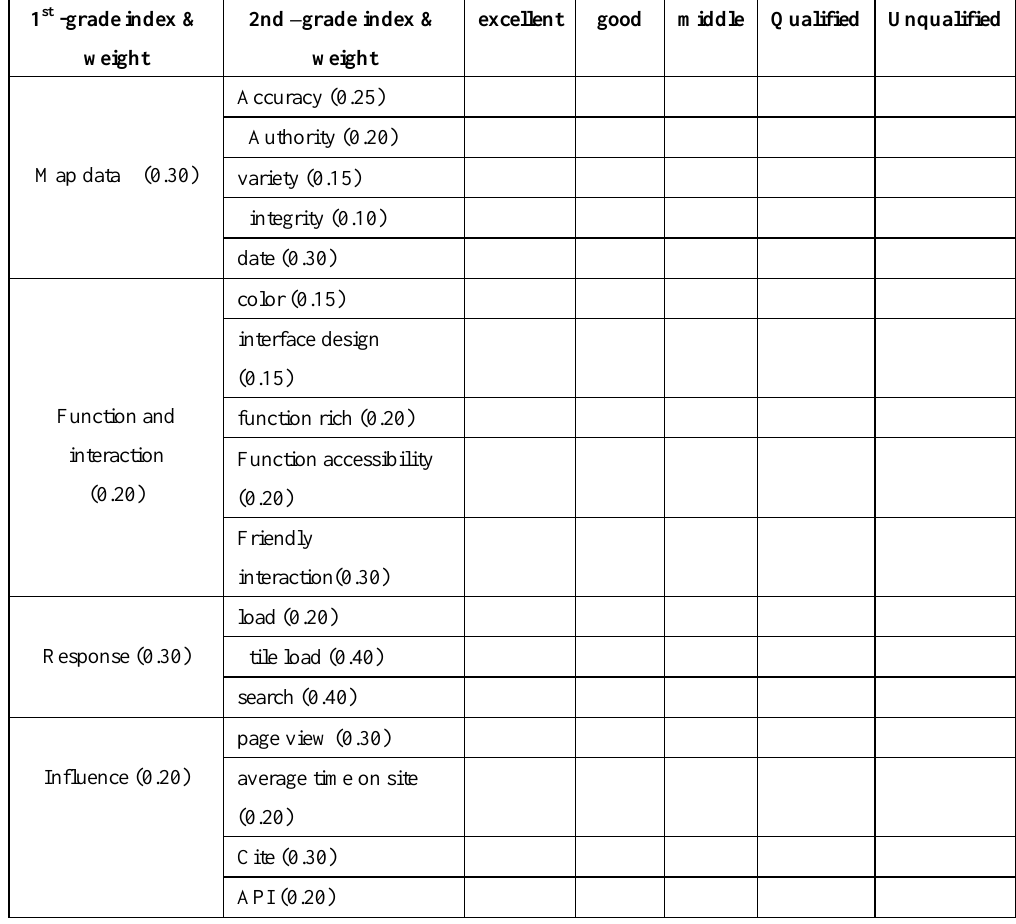
Table 2. Comprehensive evaluation index